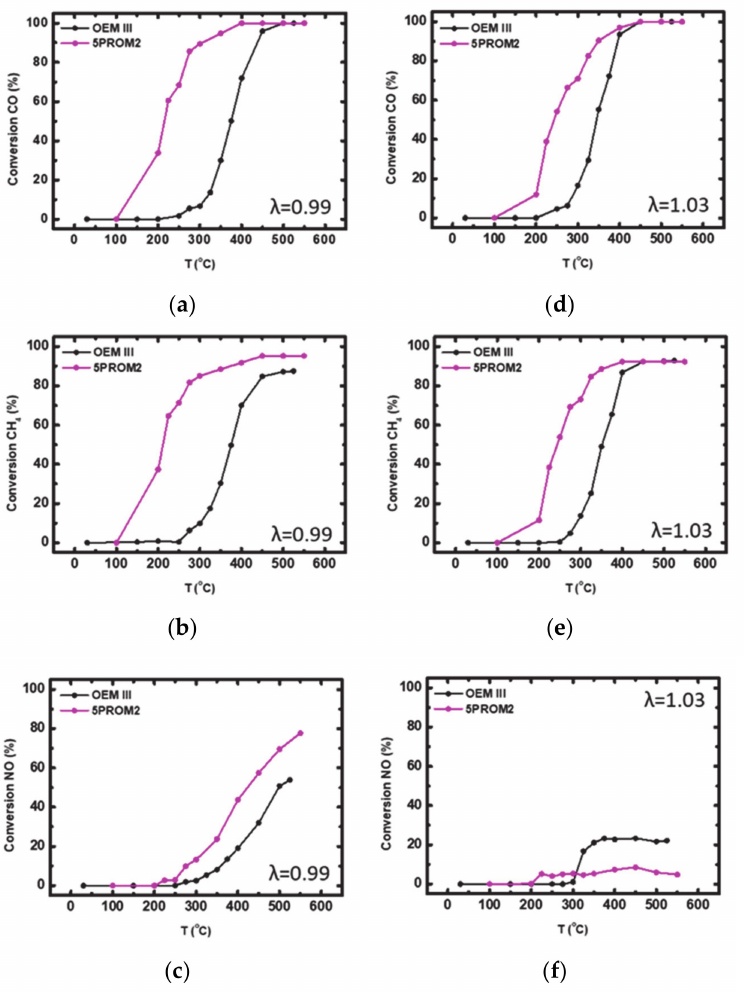
Figure 9. Light-off curves for the (%) conversion of: ( a ) CO; ( b ) CH 4 ; ( c ) NO under rich-burn conditions ( λ = 0.99); ( d ) CO; ( e ) CH 4 ; ( f ) NO under lean-burn conditions ( λ = 1.03) over commercial catalyst OEM III and PROMETHEUS Full Scale monolithic catalyst 5PROM2. Table 3. Comparison of tested catalysts OEM III and 5PROM2 under rich-burn conditions ( λ = 0.99).